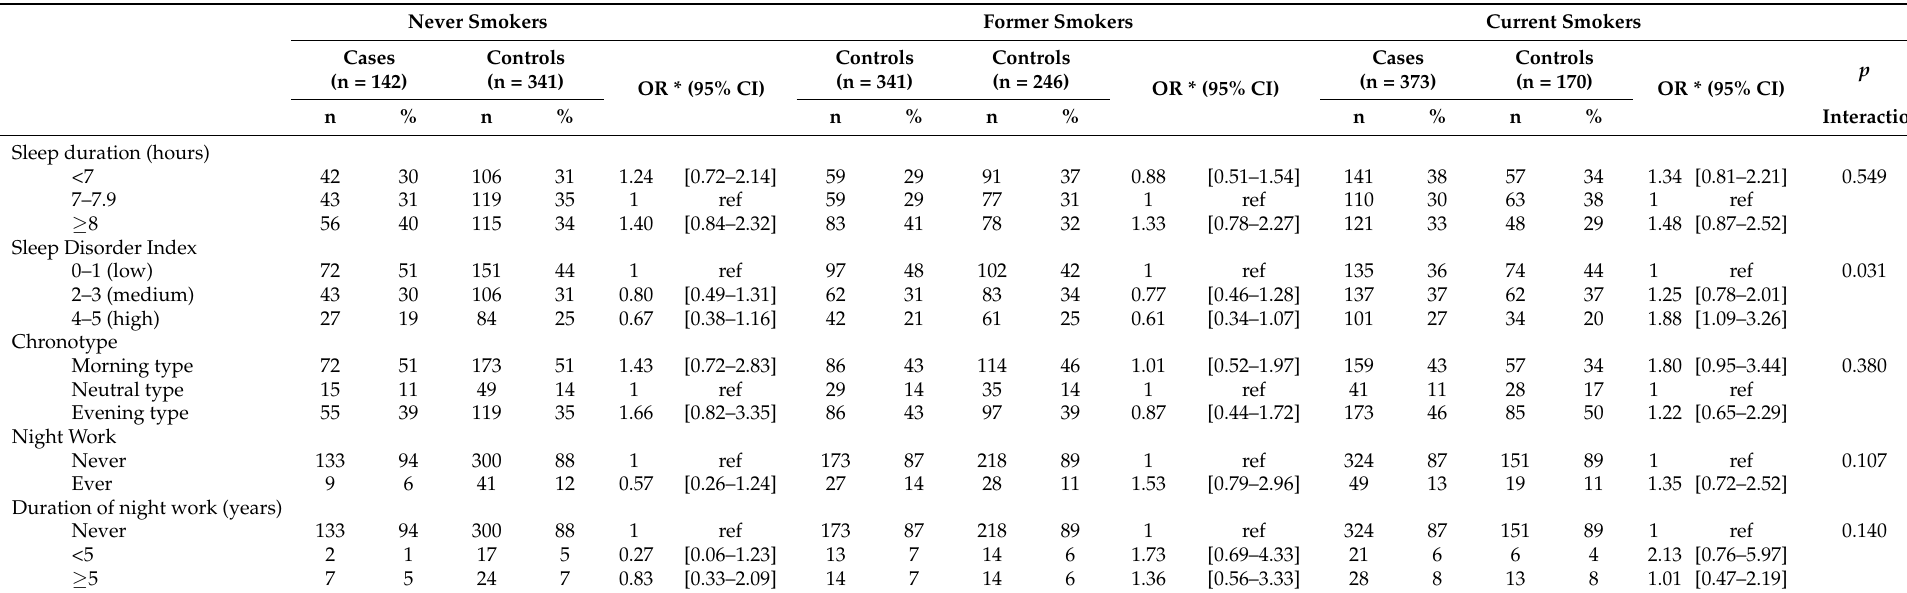
Table 3. Association between sleep traits, chronotype and night work and lung cancer according to smoking